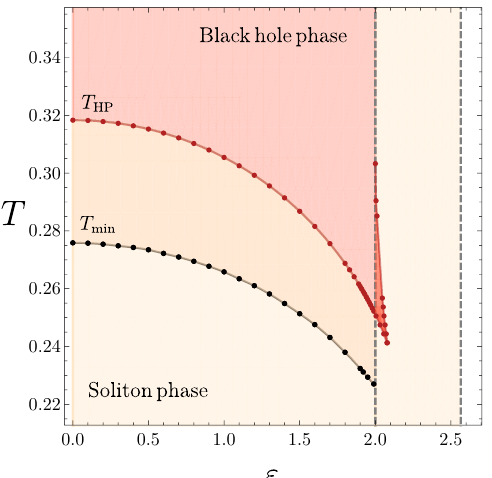
Figure 14 . Phase diagram for the rotationally polarised solutions. For " < 2, black holes ex- ist above T min ( " ) (black data points) and are the dominant phase above the T HP ( " ) curve (red area) which marks the corresponding Hawking-Page transition. Below the transition line (red data points), the dominant phase is the soliton. For " > 2, there is a cold inelastic black hole phase (red wedge). The elsewhere subdominant black holes exist up to some maximum " max ( T ), but are hidden by the soliton